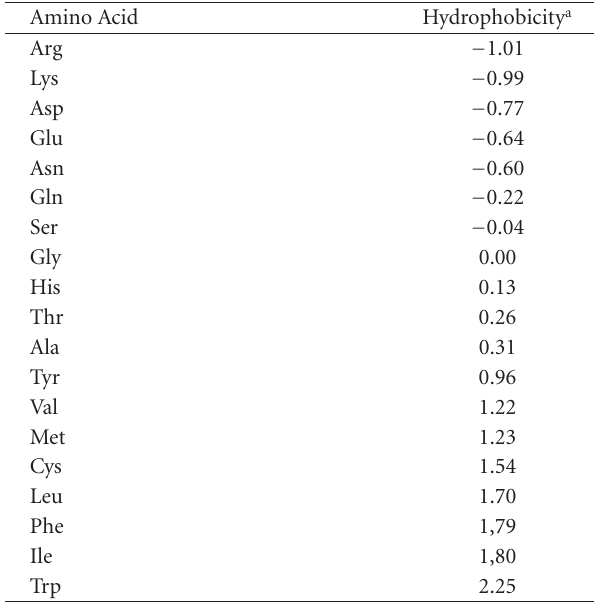
Table 1: Hydropathic states of amino acid side